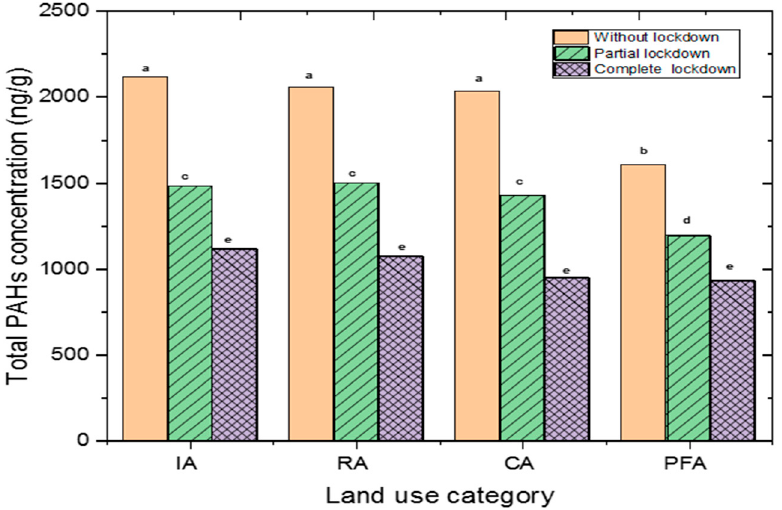
Figure 4. Total PAH distribution in various land use categories of roadway dust during lockdown and without lockdown. Significant differences are shown by bars with different letters when p < 0.05.